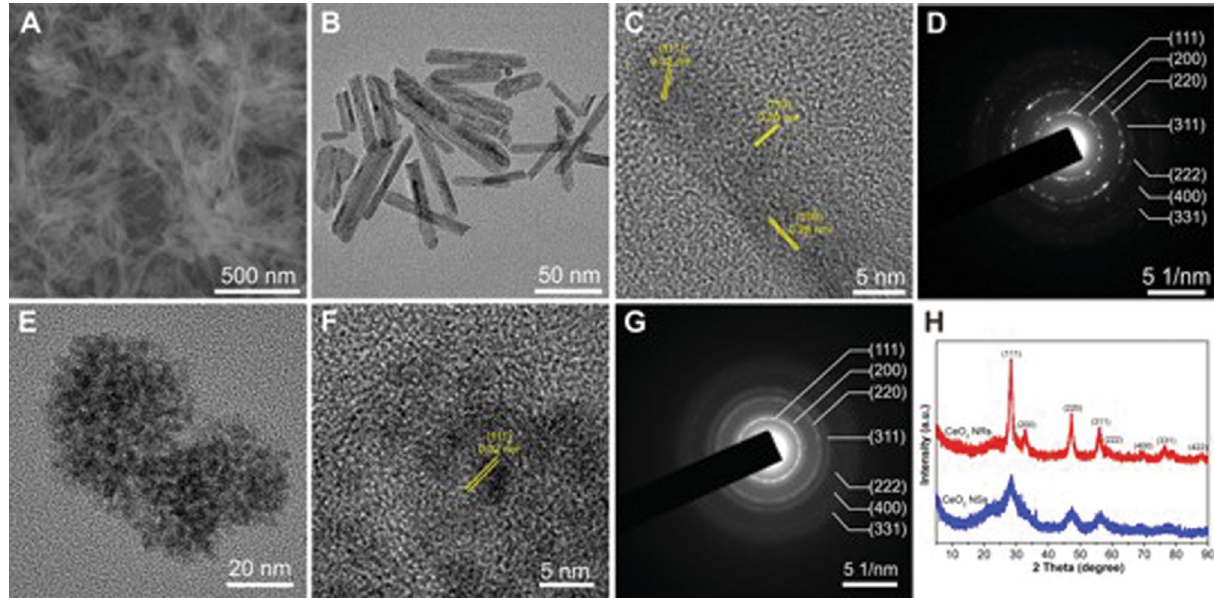
Figure 1. ( A ). SEM image of Ceria (CeO 2 ) NRs. ( B , E ) TEM images, ( C , F ) High-resolution TEM images, and ( D , G ) SAED patterns of Ceria NRs and Ceria NSs, respectively; and ( H ) PXRD patterns of Ceria NRs (in red) and Ceria NSs (in